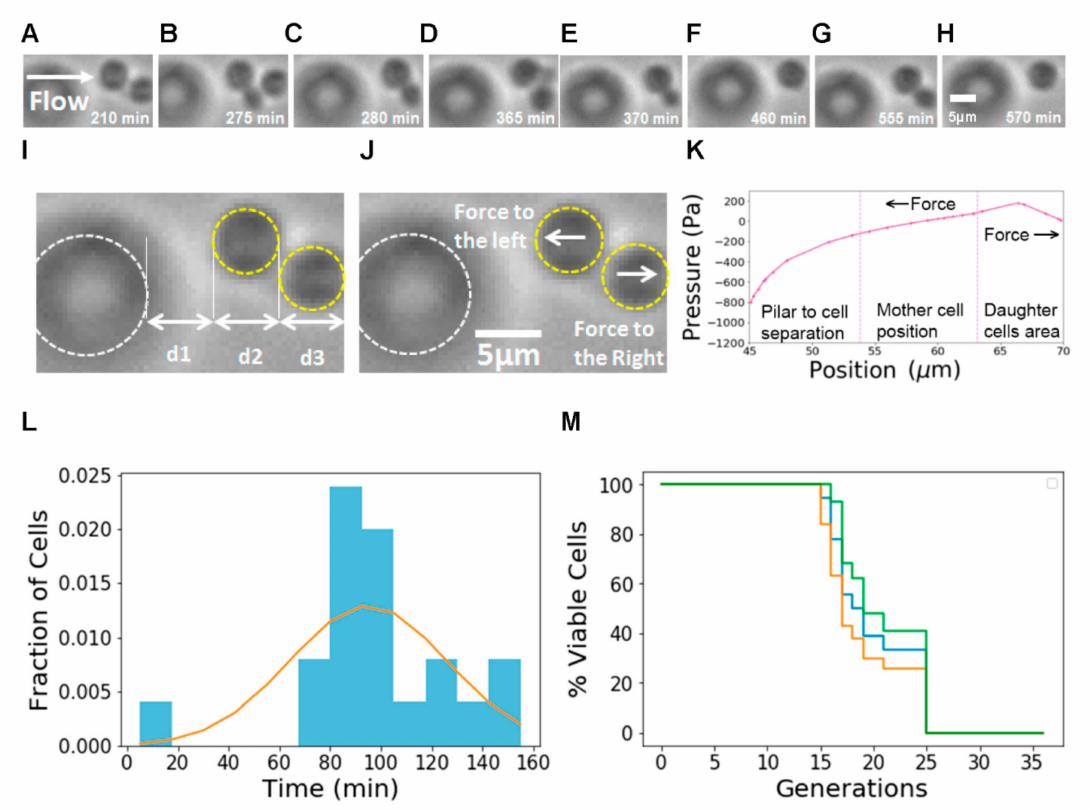
Figure 4. ( A – H ) Time-lapse Bright Field images (video frames) showing the dynamics of a single mother cell with two daugh- ters. ( A ) Mother cell with first daughter cell before detachment. ( B ) Mother cell with second daughter cell. ( C ) First daughter is detached, and second daughter continues growing. ( D ) Mother cell with third daughter cell. ( E ) Second daughter cell is detached, and third daughter cell is still growing. ( F ) Third daughter cell is detached. ( G ) Fourth daughter cell growing before detachment. ( H ) Fourth daughter cell is detached. ( I ) Pillar and cell position. PDMS pillars are highlighted in white and cells are highlighted in yellow. ( J ) Sketch of the forces felt by the cells upon detachment. ( K ) Typical pressure profile for a trap. This pressure profile was obtained from Multiphysics simulations. The leftmost section represents the distance from the pillar to the mother cell (d1 in ( I )). The central section shows the capture area of the mother cell and its approximate size (d2 in ( I )). The rightmost section shows the region where the daughter cells are born (d3 in ( I )). Mother cells are trapped due to the action of a force to the left and the daughter cells separate due to a force to the right. ( L ) Measured distribution of replication times with fit to model. ( M ) RLS measurements on our microfluidic chip. The blue line represents the Kaplan–Meier estimator, the green line represents the upper confidence interval limit and the yellow line represents the lower confidence interval